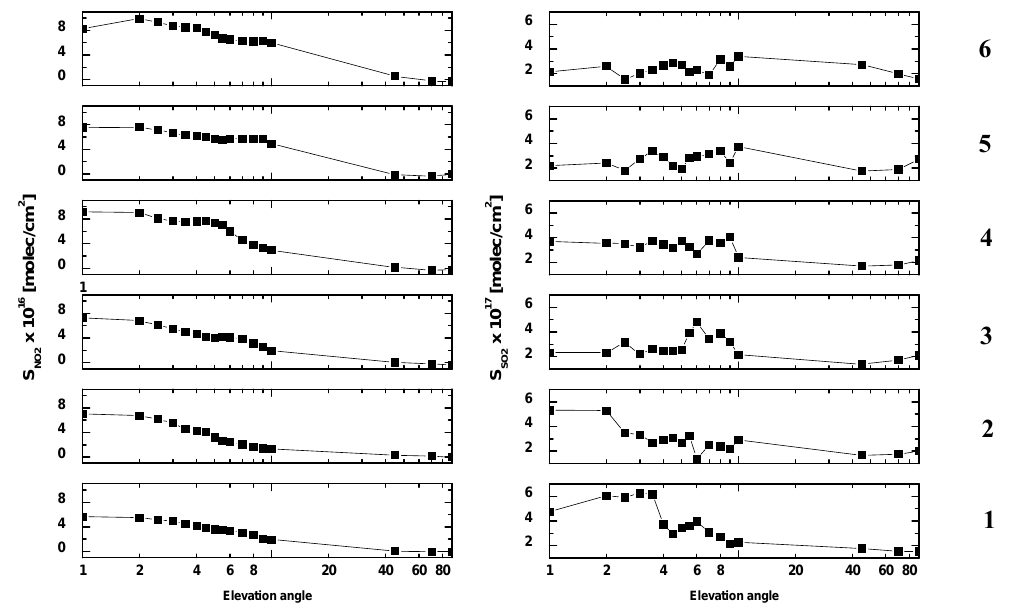
Fig. 3. NO 2 and SO 2 slant column densities by vertical scans 1 to 6 and elevation angles 1 ◦ to 90 ◦ (please notice the logarithmic scale for the elevation